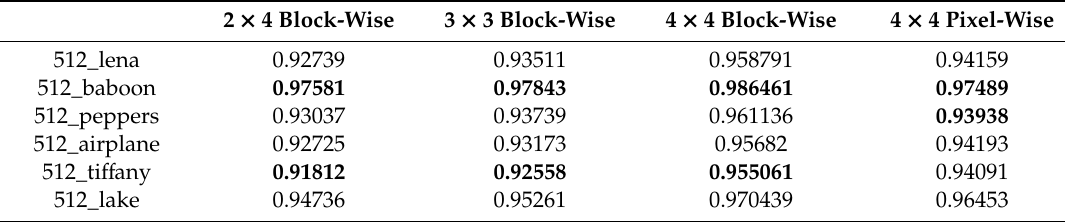
Table 5. Structural Similarity Index (SSIM) performance of proposed methods.